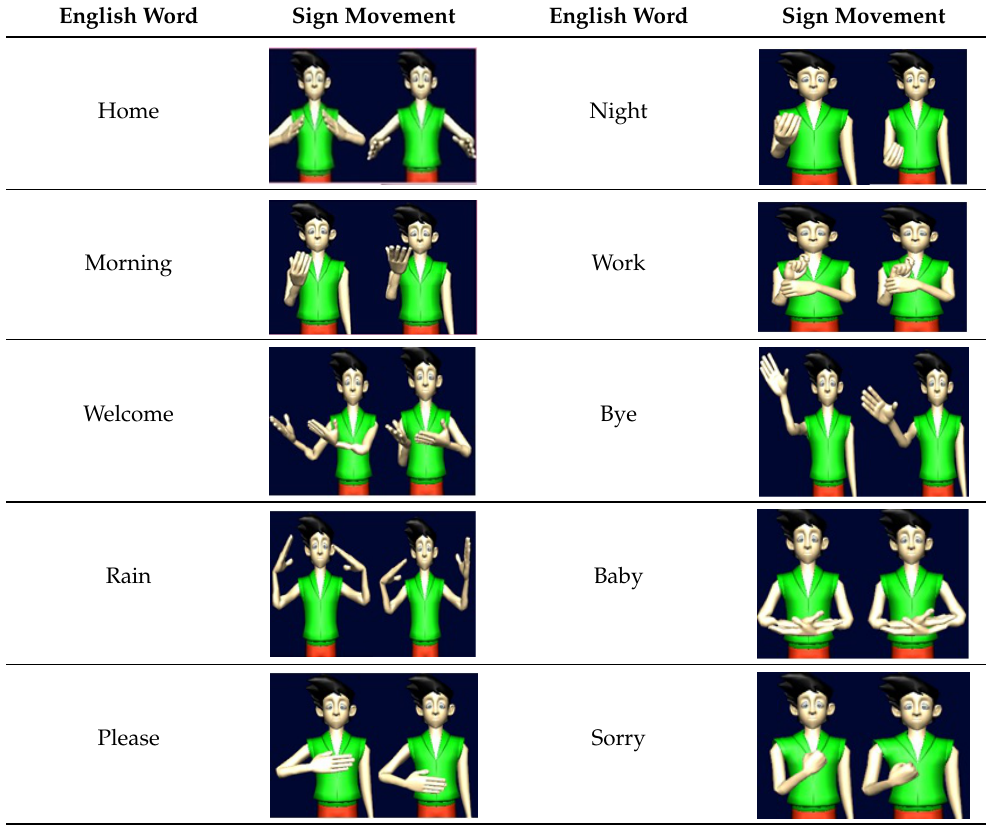
Table 5. English word to sign movements (each sign movement consists of 2 sequential